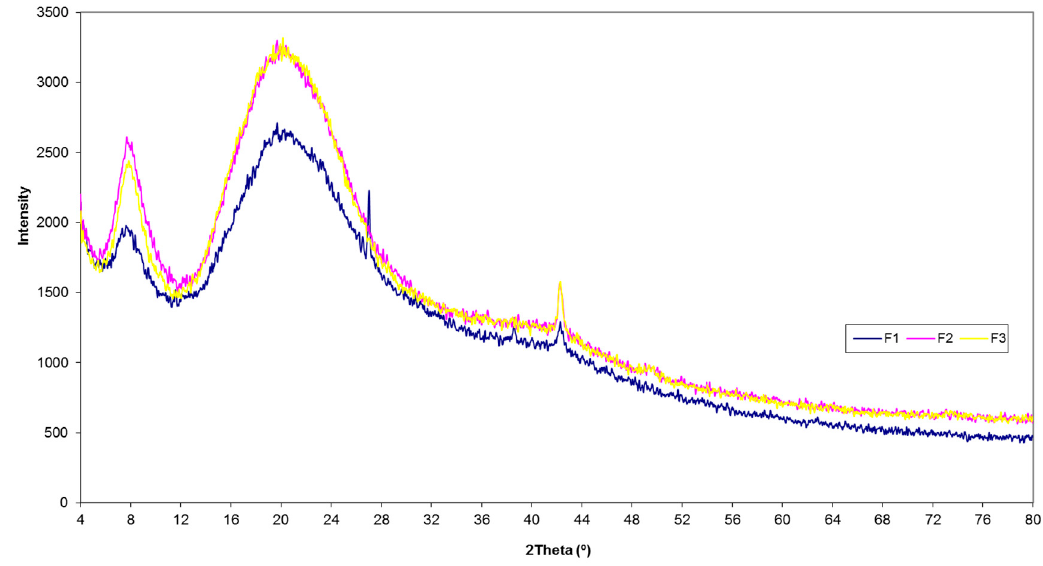
Figure 9. X-ray di ff raction spectra of F1, F2, and F3 collagen from hake Figure 9. X ‐ ray diffraction spectra of F1, F2, and F3 collagen from hake skin.